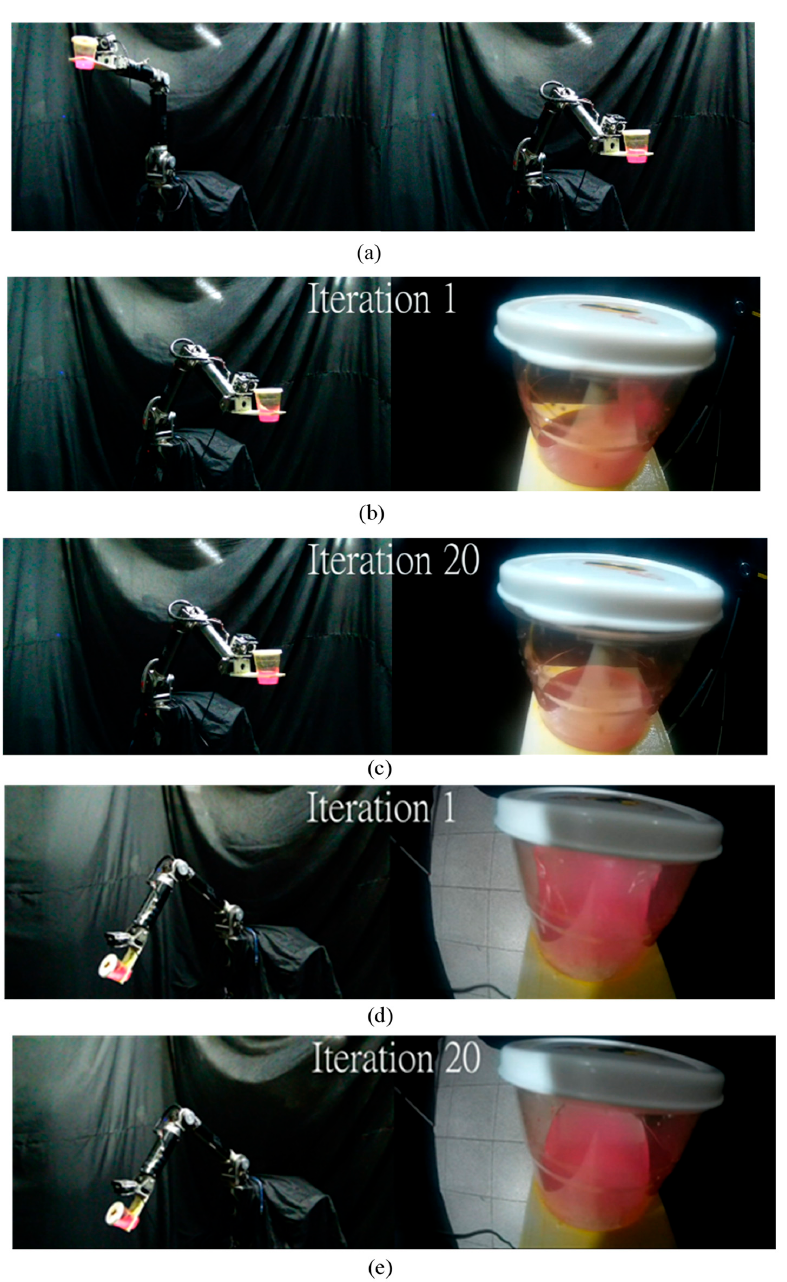
Figure 11. Experiments of multiple joint vibration suppression. ( a ) Screenshots of the movement. ( b ) Without ILC-VMD-HHT. ( c ) With ILC-VMD-HHT. ( d ) Without ILC. ( e ) With ILC.